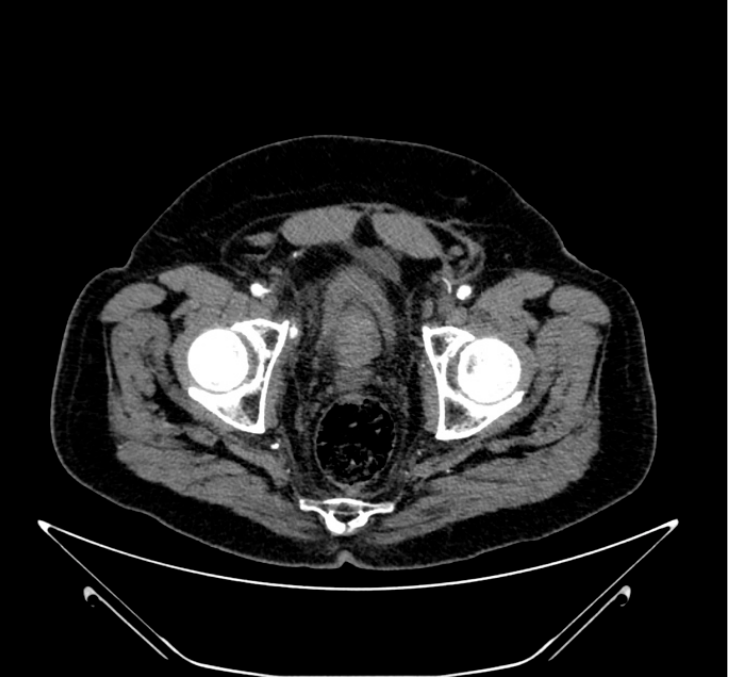
Figure 2. CT-Scan: in the arterial phase, a small hyperdense area is distinguishable in anterior obturator right region. The vessel is a deep branch of the inferior epigastric artery, and the dilatation has 5 mm of maximum length.